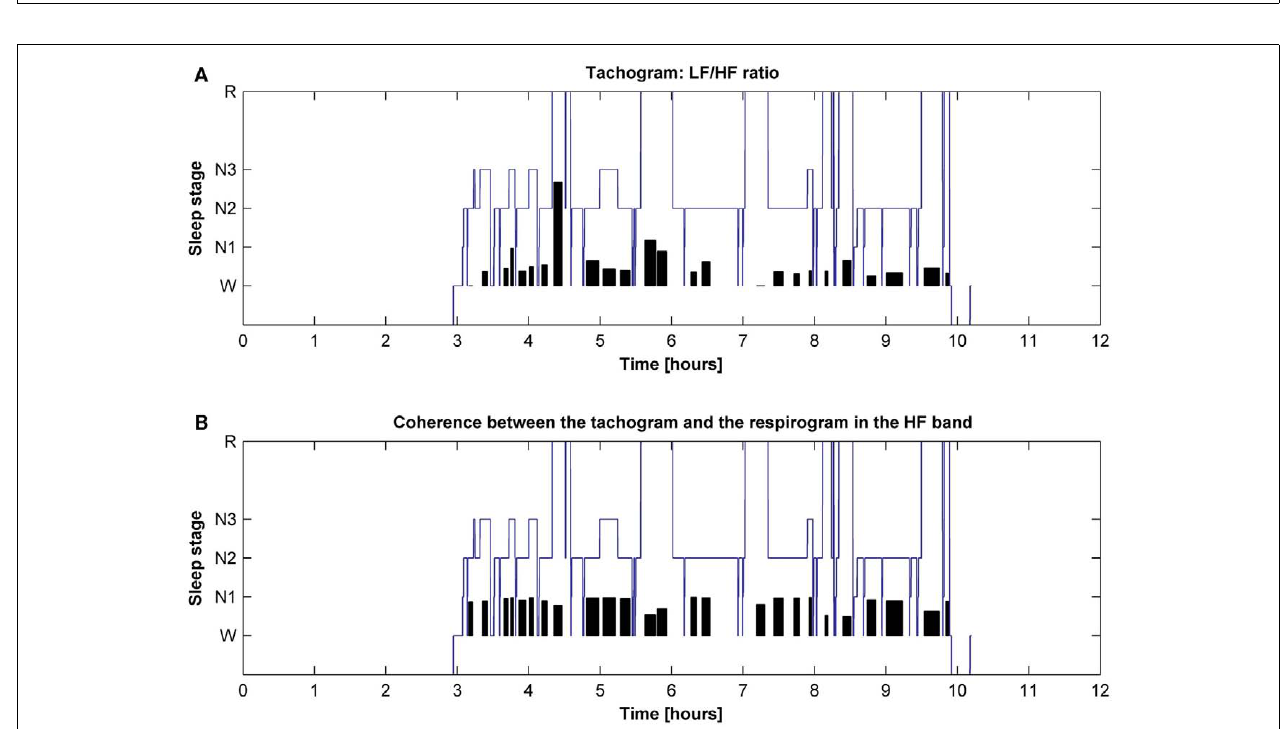
FIGURE 7 | Hypnogram of one subject with indication in black of (A) the trend of the tachogram LF/HF ratio for the whole night and of (B) the trend of the coherence between the tachogram and the respirogram in the HF band.